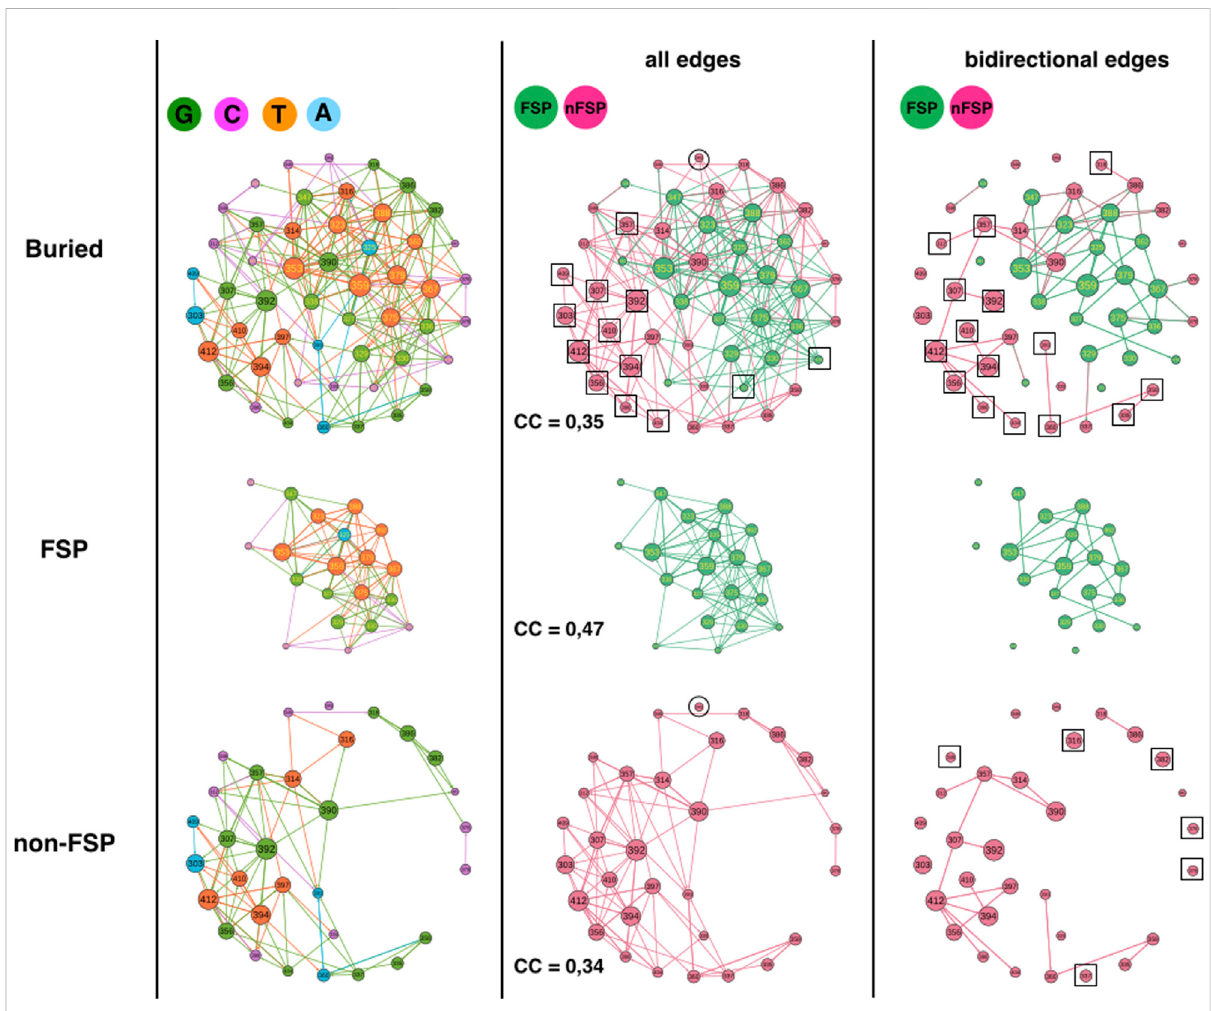
FIGURE 4 1BE9 GCAT network features of FSP and non-FSP sub-networks. The buried network, the FSP and non-FSP sub-networks are shown on the upper, middle and lower panels, respectively. The left, middle and right columns are the GCAT classi fi cation, all in fl uences and bidirectional mutual in fl uences,respectively.Thesquareboxesindicatenodesthatareinvolvedinhomogeneousin fl uencesonly(i.e.,edgesFSPtoFSPoredgesnon-FSP tonon-FSP),thecirclesindicatenodesthatareinvolvedinheterogeneousin fl